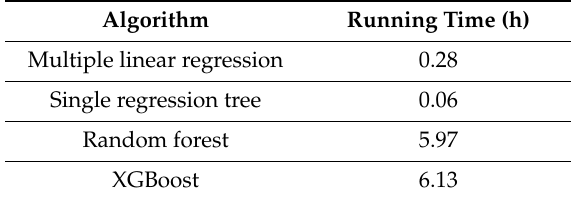
Table 8. Computational power recorded for di ff erent models over ten iterations and 5-fold cross validation.